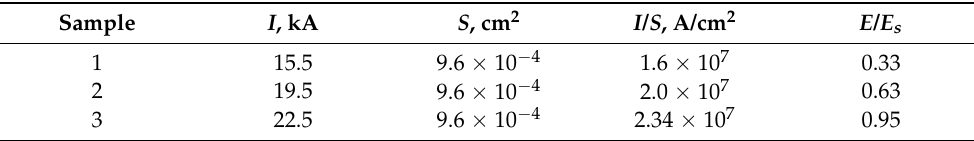
Table 2. Parameters of the Electrical Explosion of the Aluminum Wires